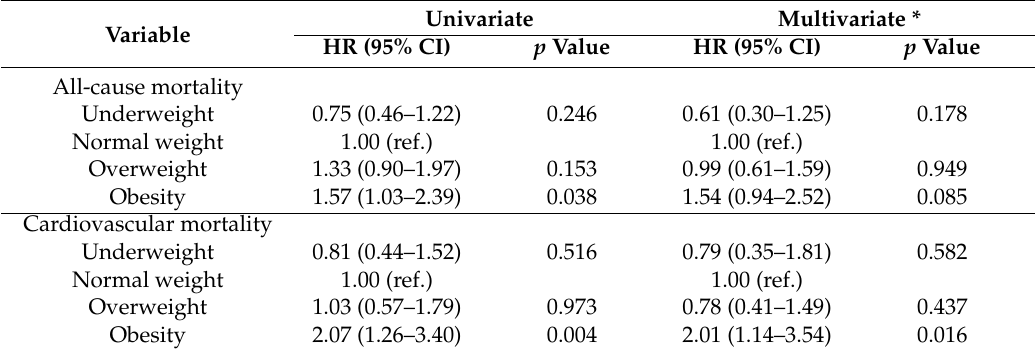
Table 2. Association between baseline BMI categories and all-cause and cardiovascular mortality.